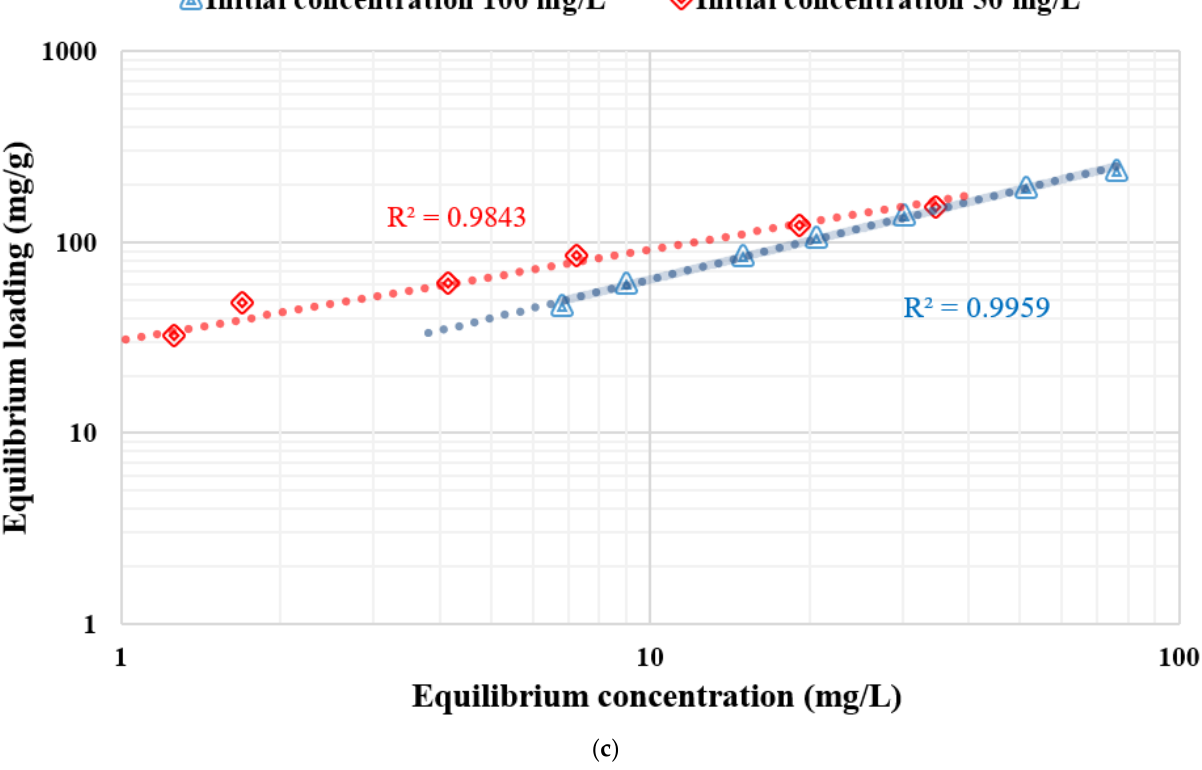
Figure 20. Freundlich adsorption isotherm for direct blue 78 dye removal using adsorbents ( a ) chi- tosan, ( b ) nanocellulose, and ( c ) CCMB-0.25:1.